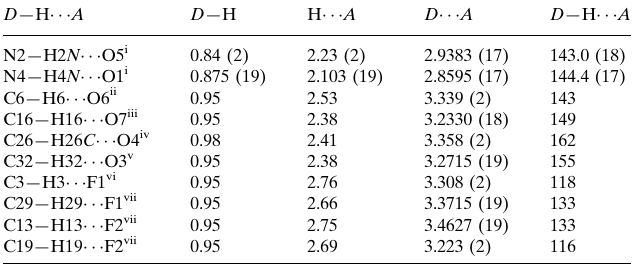
H ClFN O S, crystallizes with two 16 12 2 4